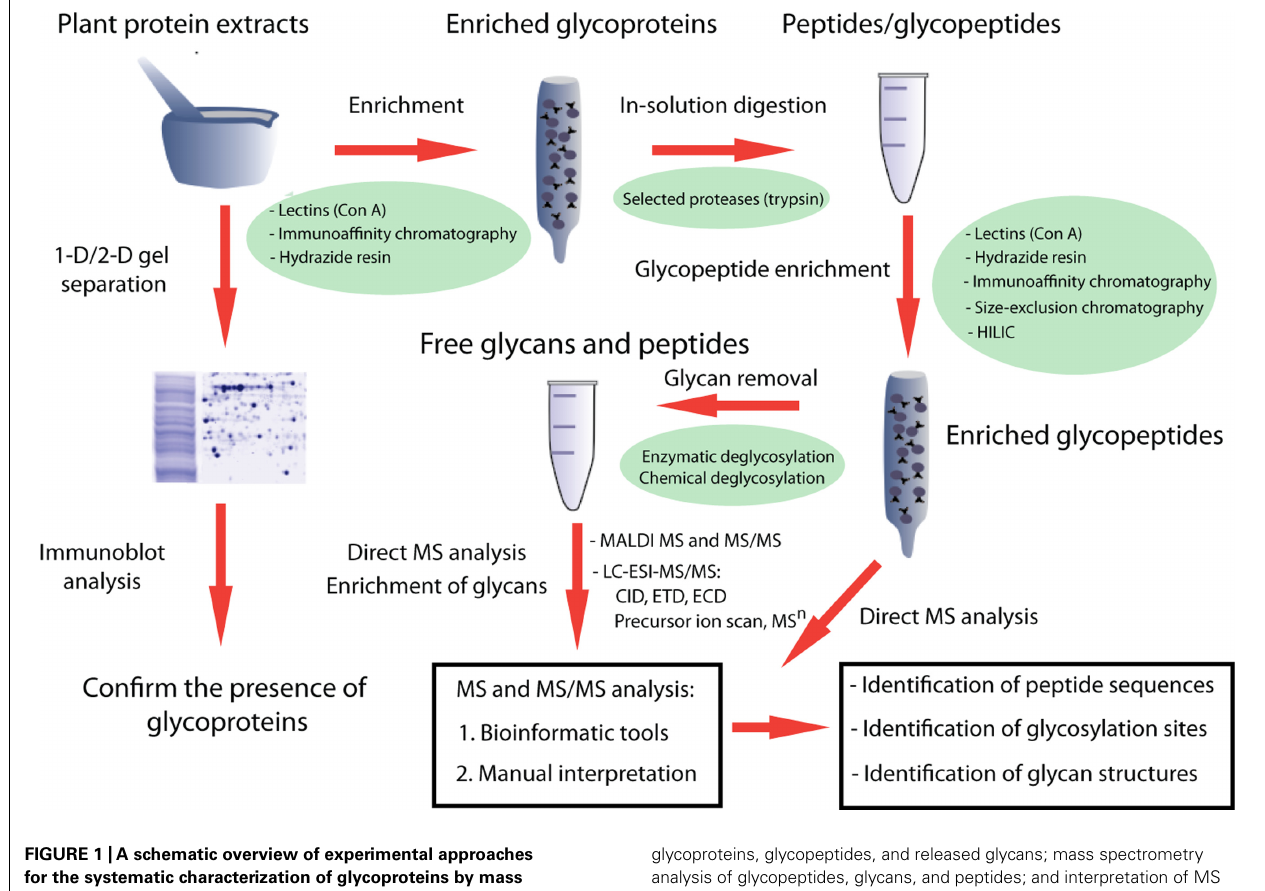
glycoproteins, glycopeptides, and released glycans; mass spectrometry analysis of glycopeptides, glycans, and peptides; and interpretation of MS